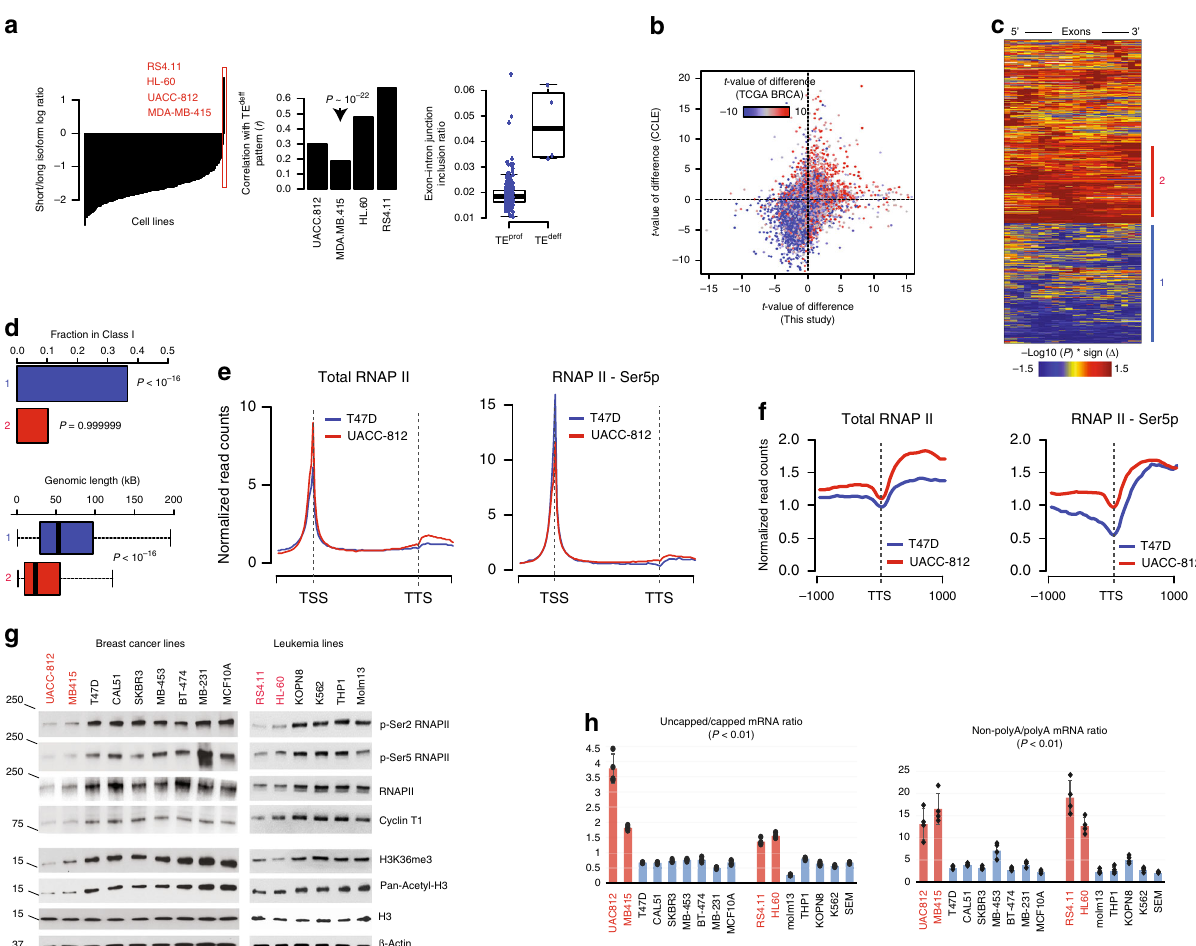
Fig. 3 TE deff is observed in some cancer cell lines and correlates with defects in mRNA transcription, processing, and export. a Left: cell lines are ordered based on the average short/long isoform ratio for the AT genes. Four with the highest scores are highlighted. Middle: correlation of the transcriptional patterns (every gene is z-normalized to the rest of the cell lines) of candidate TE deff cell lines with the average TE deff signature (average t-statistic of TE deff vs. TE prof expression difference for every gene). The p -value of correlation (Spearman) for the cell line with the lowest correlation is shown. Right: quanti fi cation of intron – exon junction inclusion ratio in Class I genes (same as in Fig. 1h) in TE prof and TE deff cell lines. b Three-way correlation of TE deff - speci fi c transcriptomic signatures ( t -values of difference in TE deff vs. TE prof cells for every gene) obtained for breast cancer cell lines based on RNAseq data from CCLE ( y -axis), based on our independent RNAseq ( x -axis) and based on RNAseq data from TCGA breast cancer (BRCA) dataset (color-mapped based on the color key). c Differential exon expression heatmap (see Fig. 1c) of TE deff and TE prof breast cancer lines obtained from our independent RNAseq data. Genes with spurious and overexpressed expression patterns are highlighted (blue and red, respectively). d Enrichment of the spuriously transcribed (blue) and overexpressed (red) genes in c for the Class I genes from the tissue samples. The p -values re fl ect one-sided hypergeometric distribution, i.e. closer to 0 indicates enrichment, closer to 1 indicates depletion. e Genome-wide distribution plots of total and phospho-Ser5 RNAP II in a TE deff (UACC-812) and a TE prof (T47D) cell line. f Genome-wide distribution of total and phospho-Ser5 RNAP II around the transcription termination site (TTS) regions of genes in TE deff and TE prof cells. g Immunoblotting of indicated RNAP II and histone marks in the indicated cell lines. TE deff cells are highlighted in red. h Ratios of 5 ′ -uncapped to 5 ′ -capped (left) and 3 ′ -non-polyadenylated to 3 ′ -polyadenylated (right) mRNA concentrations after rRNA depletion in the indicated cell lines. P : difference between TEdeff and TEprof cell line values ( t -test). Error bars: standard deviation based on four technical